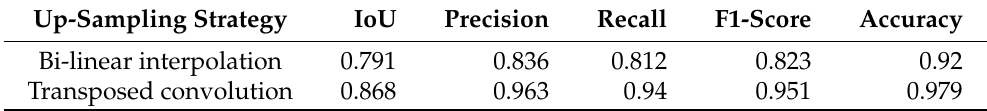
Table 4. Effect of up-sampling